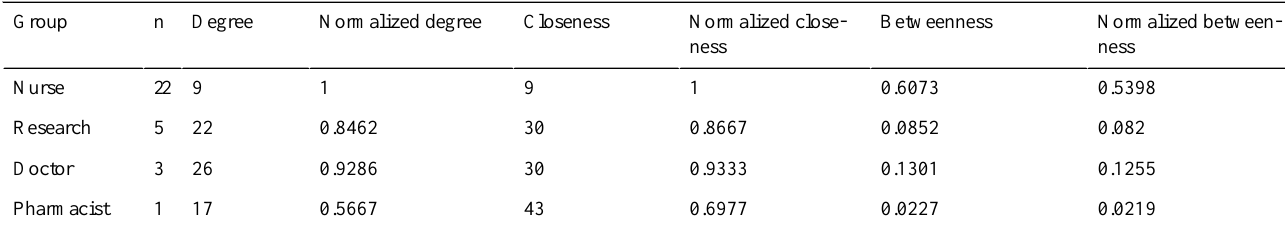
Table 7. Occupation centrality indicators.